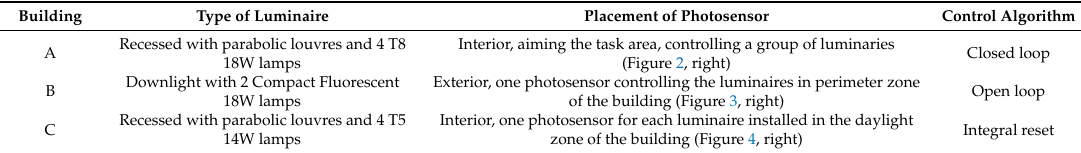
Figure 4. Interior space ( left ), exterior façade ( middle ) and position of the photosensor ( right ) for Building C. Table 1. Technical characteristics of lighting system and daylight harvesting equipment.